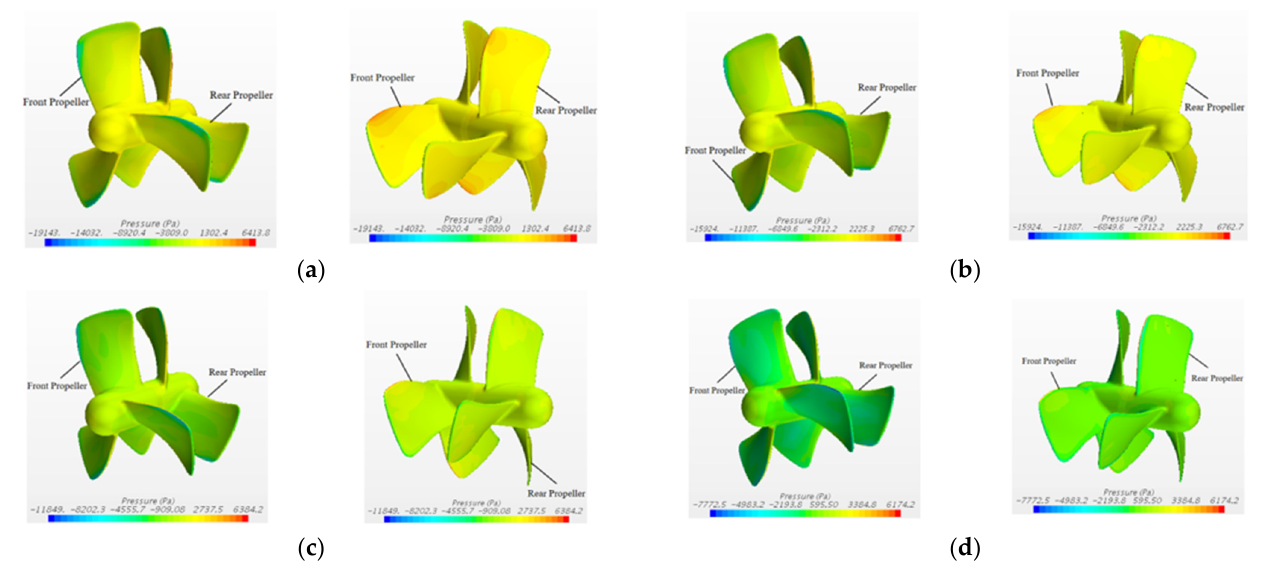
Figure 23. Pressure distribution on the CRP surfaces with different advance coefficients, J = 0.1 ( a ), J = 0.3 ( b ), J = 0.5 ( c ), and J = 0.7 ( d ). Figure 24. Wake streamline distribution of CRP, J = 0.1 ( a ), J = 0.3 ( b ), J = 0.5 ( c ), and J = 0.7 ( d ).